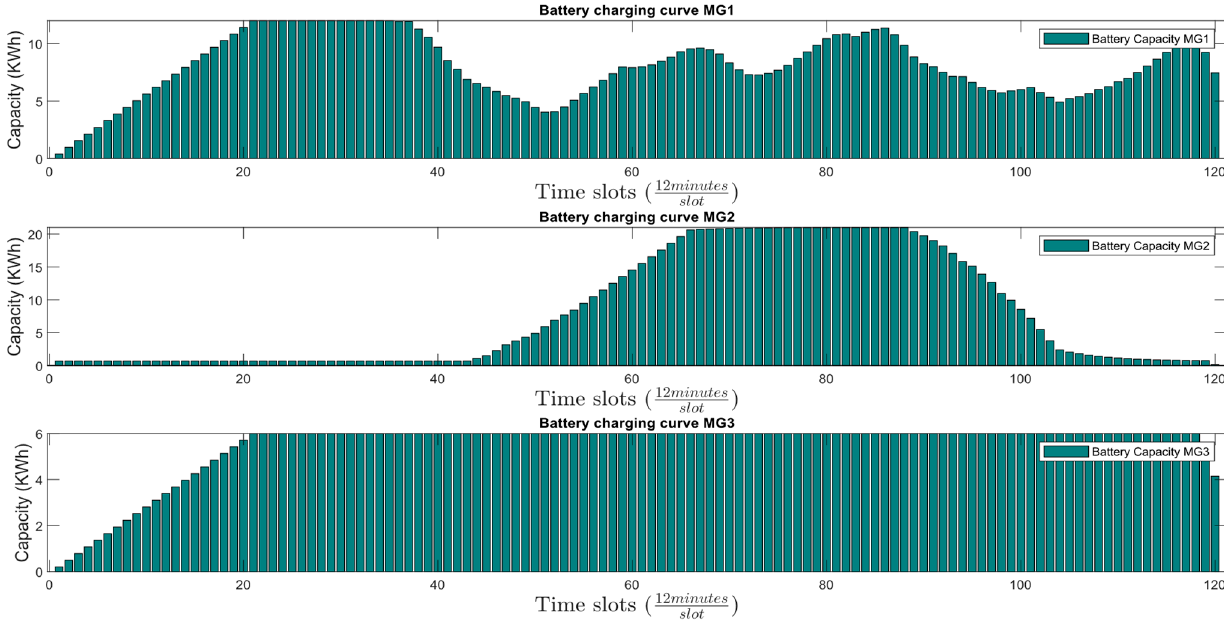
Figure 25. BESS capacity per slot for scheduled load in scenario 3 .